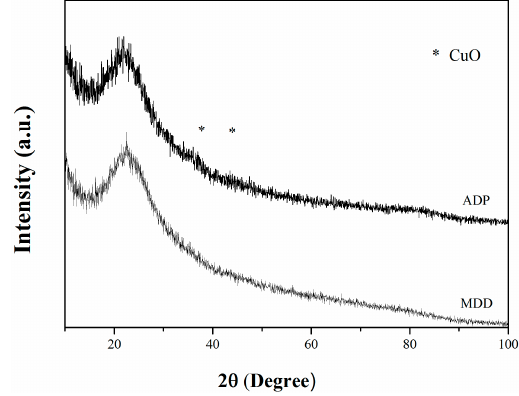
Figure 2. X-ray diffraction patterns of the CuO/SBA-15 materials prepared by ADP method (top) and Figure 2. X ‐ ray diffraction patterns of the CuO/SBA ‐ 15 materials prepared by ADP method (top) and MDD method MDD method (bottom).